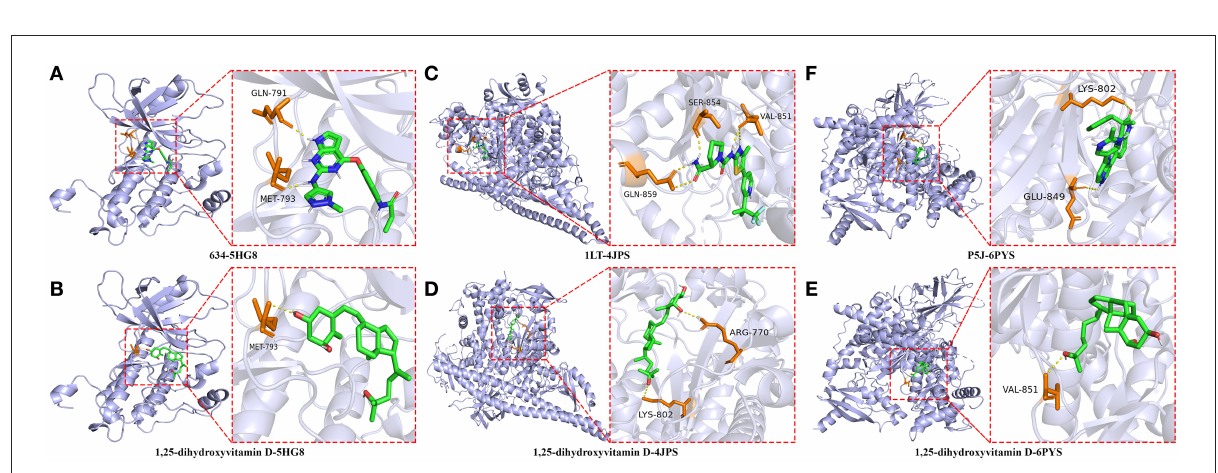
FIGURE8 Molecular docking details of the original ligands and 1,25-dihydroxyvitamin D to the target protein. 634-5HG8 (A) , 1,25-dihydroxyvitamin D-5HG8 (B) , 1LT-4JPS (C) , 1,25-dihydroxyvitamin D-4JPS (D) , P5J-6PYS (E) , 1,25-dihydroxyvitamin D-6PYS (F) .